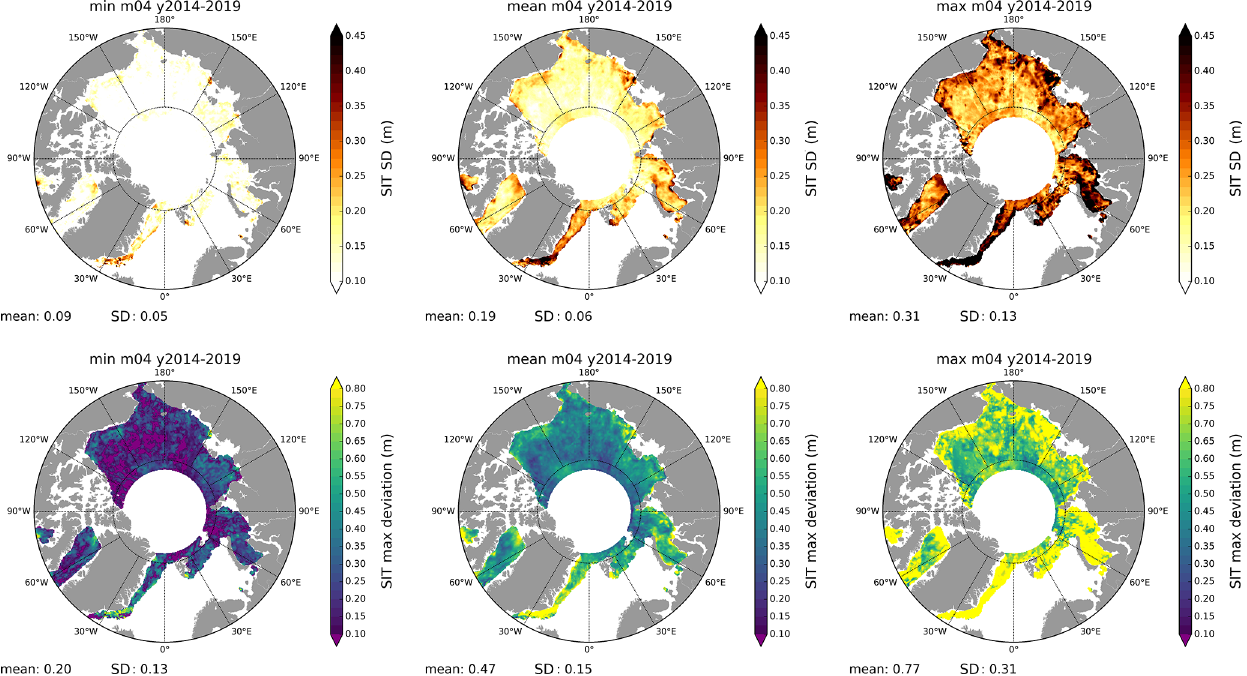
Figure 12. Interannual minimum (min ( SD m ) , first column), mean (SD m , second column) and maximum (max ( SD m ) , third column) maps of the standard deviation (first row) and the maximum deviation (second row) for the month of April (m = 04). The snow products used to compute the maps are ASD, DuST, AMSR2B and W99m. These maps correspond to the case “obs snow